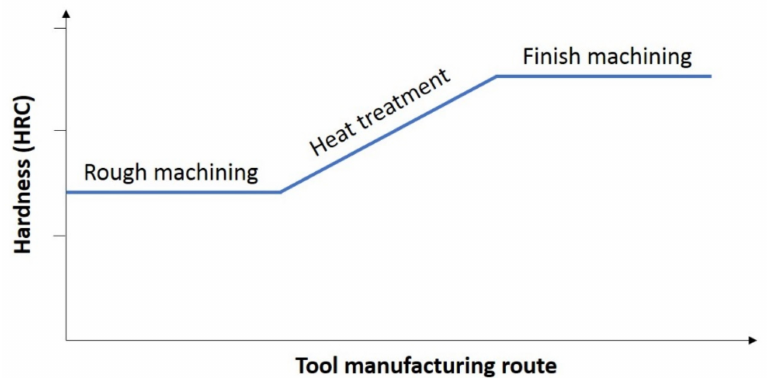
Figure 1. Regular manufacturing route of forming tools.